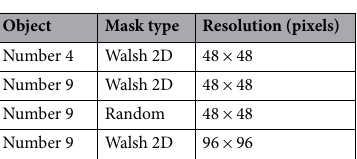
Table 1. Summary of experimental parameters that were varied during the